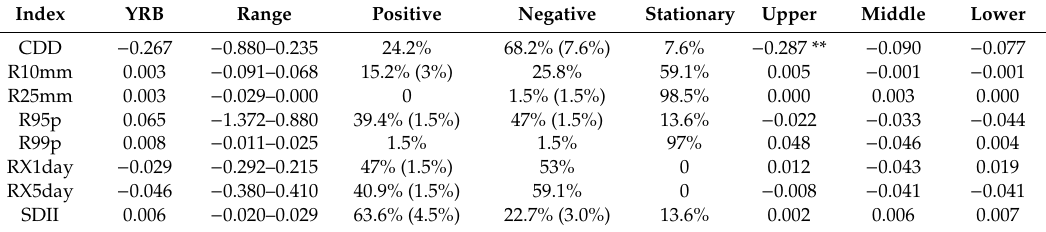
Table 2. Percentage of stations with positive (significant at the 0.01 level), negative (significant at the 0.01 level), and stationary trends for the trend test in annual extreme precipitation indices during